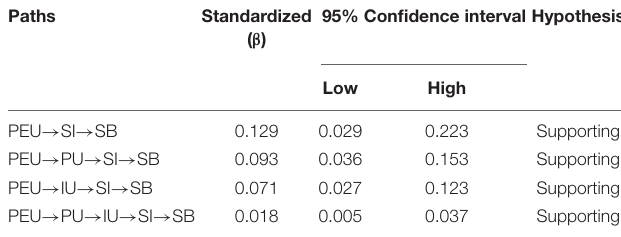
TABLE 3 | Bias-corrected bootstrap tests on the direct and indirect